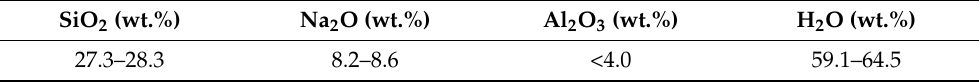
Table 2. Chemical composition of the sodium silicate solution.